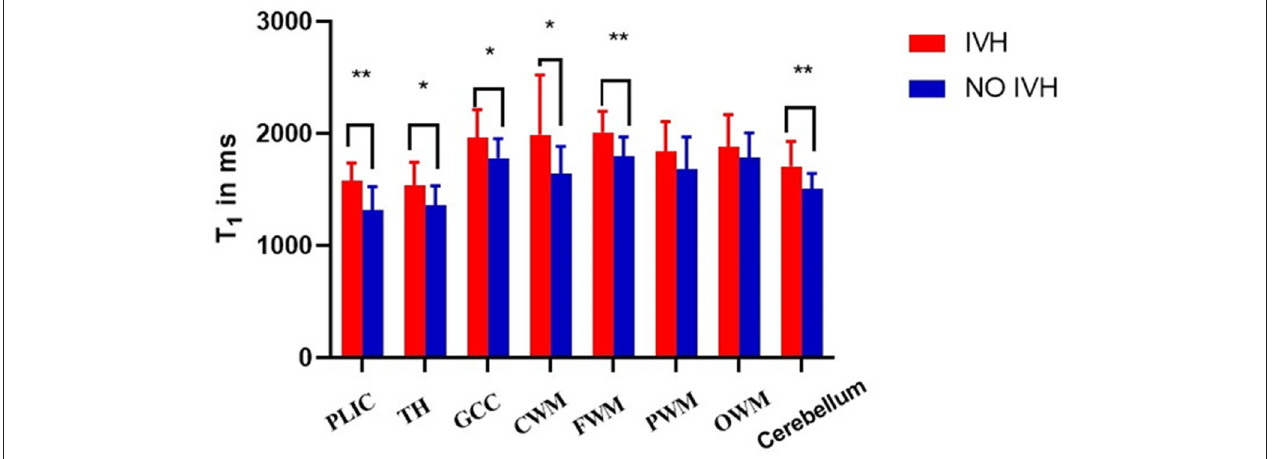
FIGURE 2 | Differences in T1 values between IVH and NON IVH groups. The IVH group is displayed in red and the NON IVH group in blue. PLIC, posterior limbs of the internal capsule; TH, thalamus; GCC, genu of the corpus callosum; CWM, Central white matter; FWM, frontal white matter; PWM, parietal white matter; OWM, occipital white matter. * p < 0.05,** p <